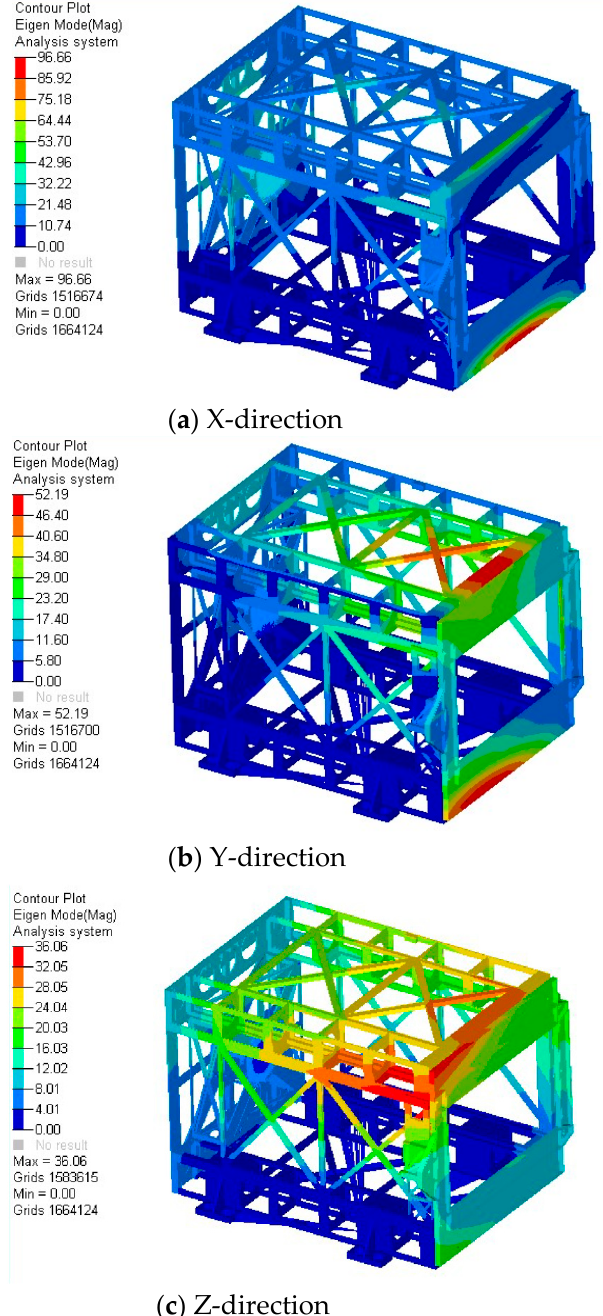
Figure 9. First three-order natural frequencies of combination.